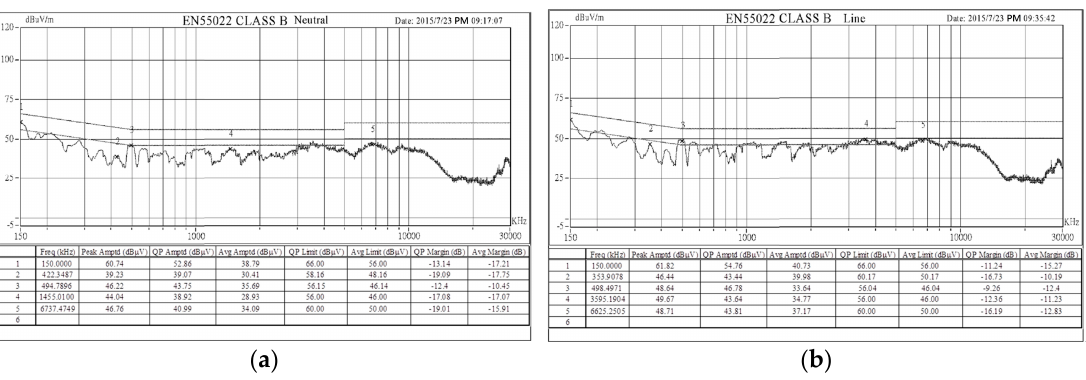
Figure 21. Conducted EMI measurements in the X -capacitor of 0.33 μ F (±9% frequency swapping): ( a ) neutral; ( b ) line.